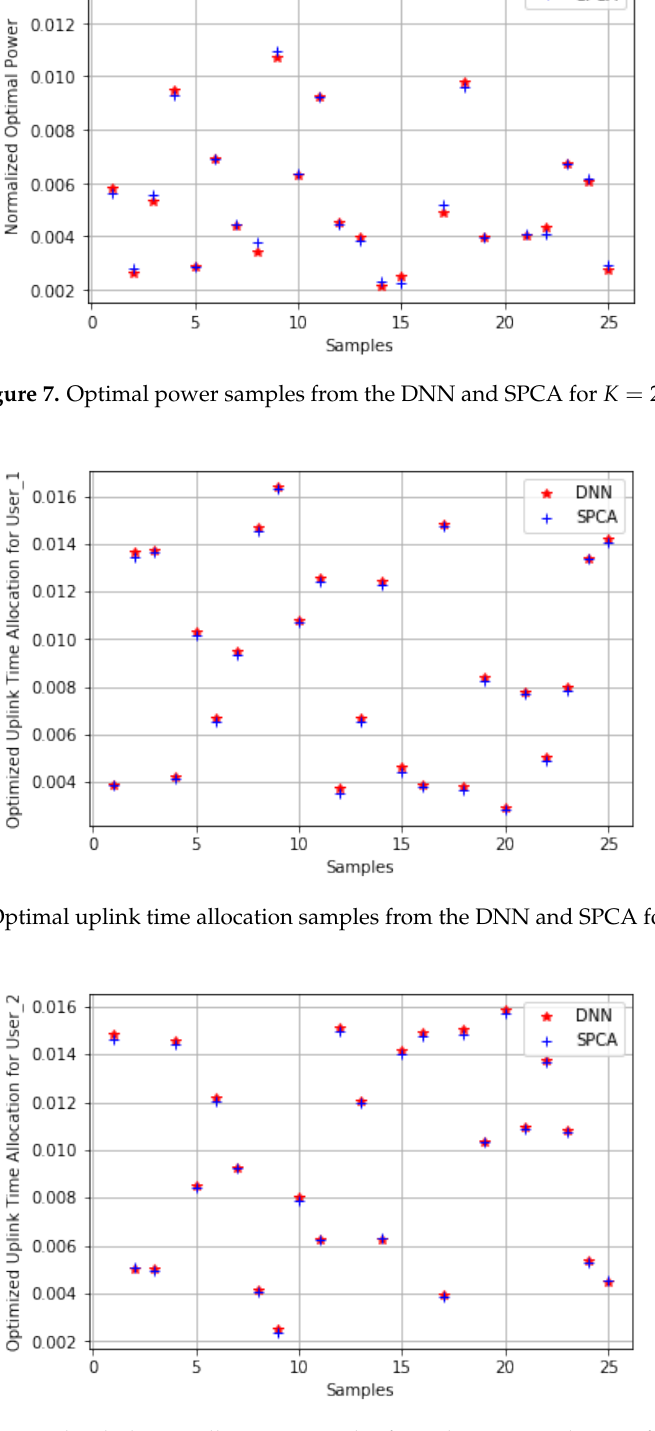
Figure 9. Optimal uplink time allocation samples from the DNN and SPCA for User